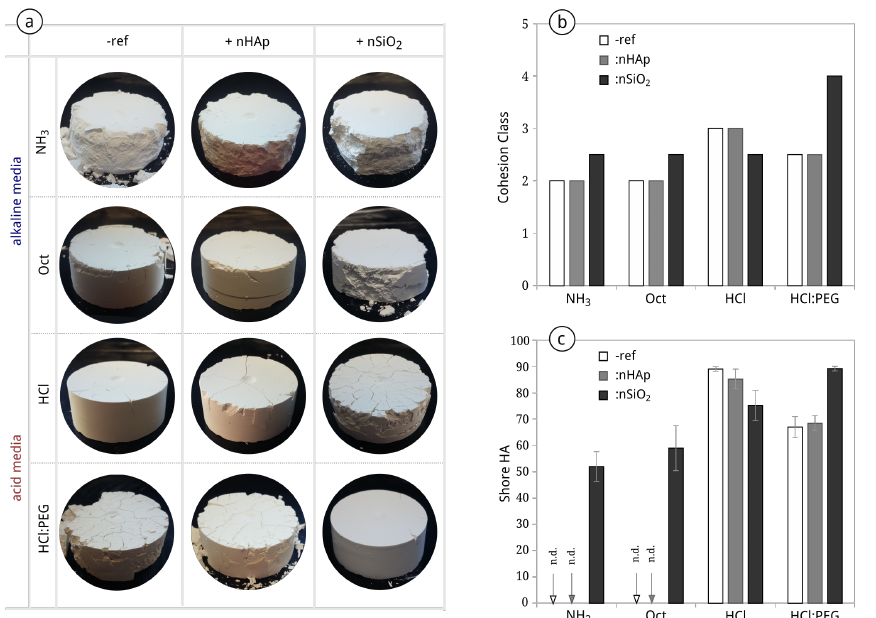
Figure A2. Results obtained from the calcite blends produced with the prepared formulations: ( a ) side view of the blends’ monoliths, ( b ) cohesion class, and ( c ) the Shore A hardness (HA)